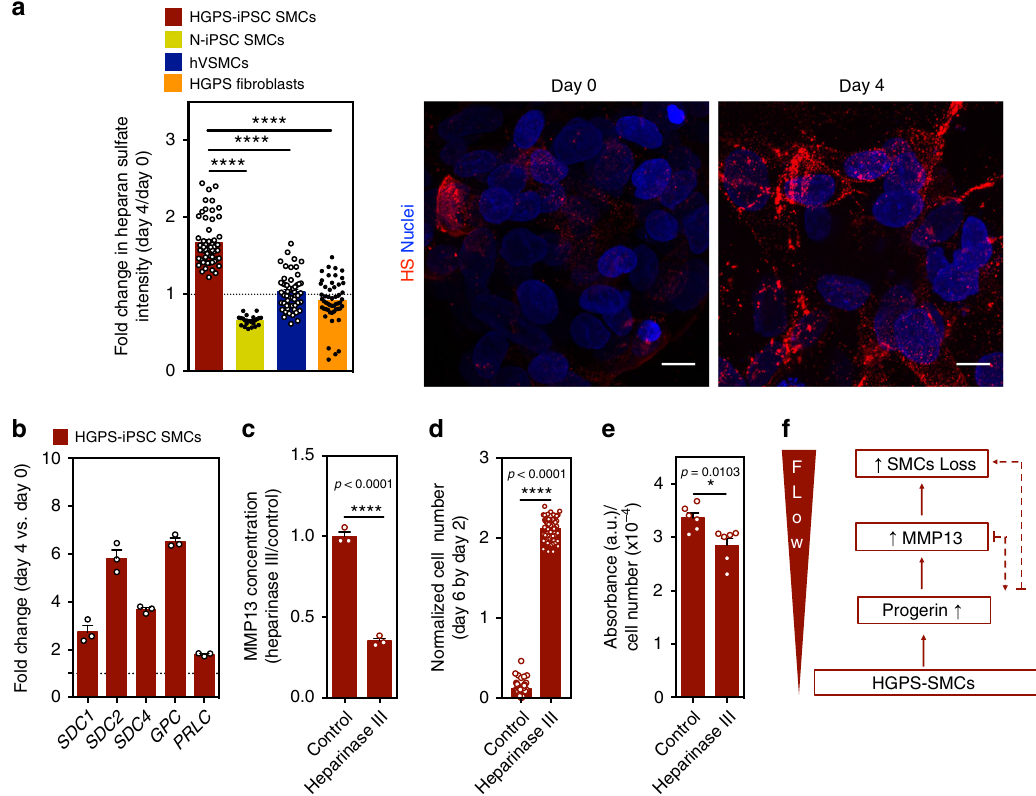
Fig. 8 MMP13 expression in SMCs is triggered by an increase in heparan sulfate. a Cells were cultured under fl ow conditions for 4 days and the expression of heparan sulfate was evaluated by immuno fl uorescence. Intensity of heparan sulfate was calculated in each picture and normalized by cell number. The normalized fl uorescence intensity at day 4 was divided with the one at day 0. Scale bar is 10 μ m. n > 4 images examined over six